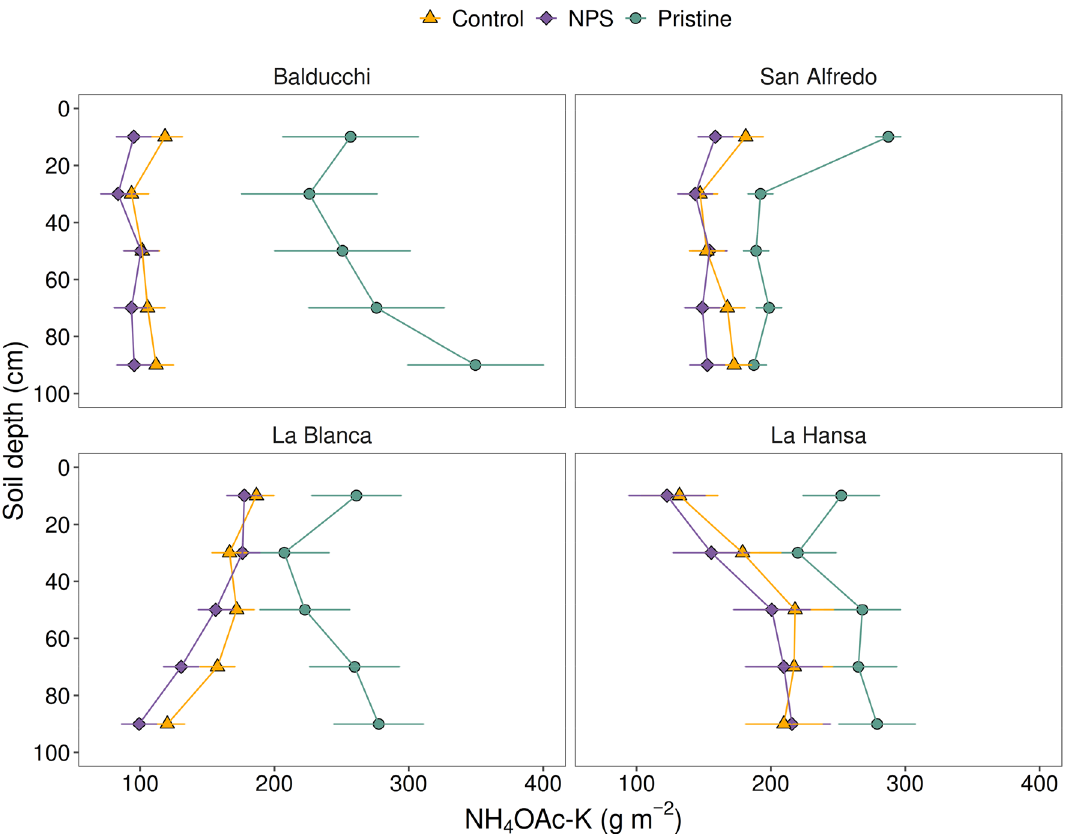
Figure 2. Soil profiles of NH 4 -OAc-K (g m −2 ) under three different conditions: pristine soils (green circles), under grain cropping from 2000 to 2009 with no fertilizers added (Control, orange triangles), and under grain cropping from 2000 to 2009 with N, P, plus S fertilization (NPS, purple diamonds). Overlapping error bars indicate absence of significant differences between scenarios by soil depths combinations (Tukey’s HSD, p <